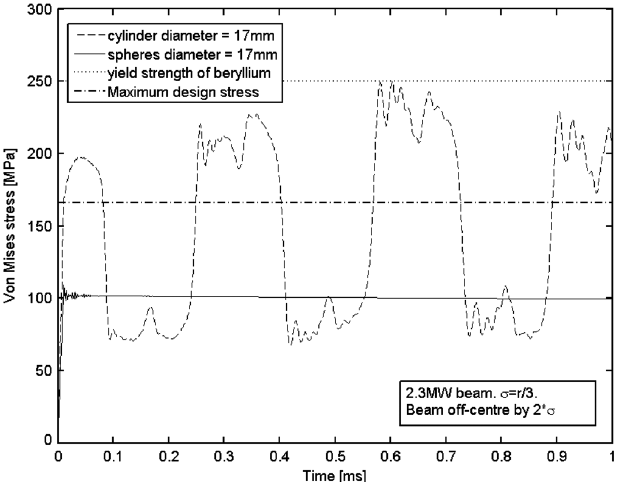
FIG. 2. Maximum Von Mises stress (including thermal and inertial components) in a beryllium cylinder and sphere both of the same diameter.